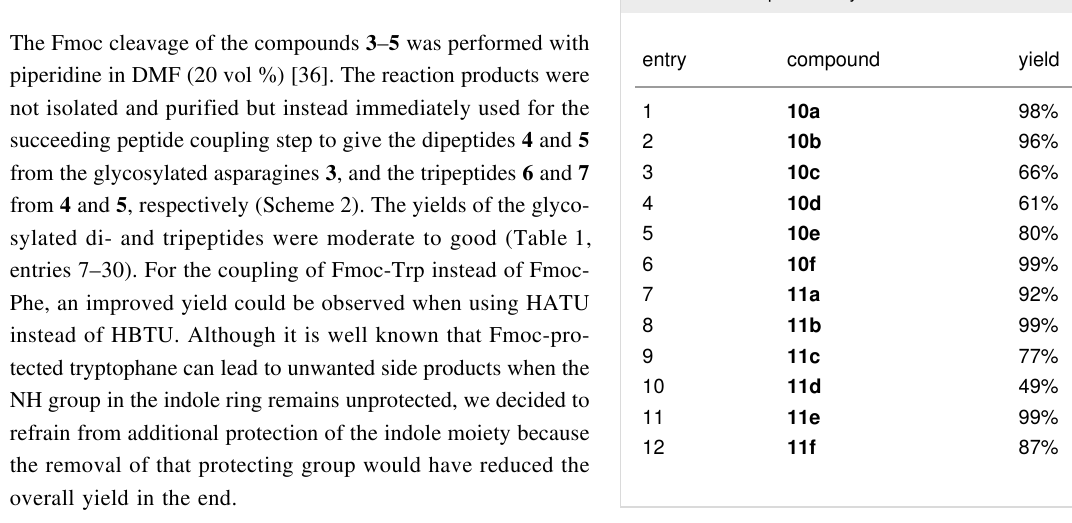
Table 2: Final deprotection yields of 10a – f and 11a – f